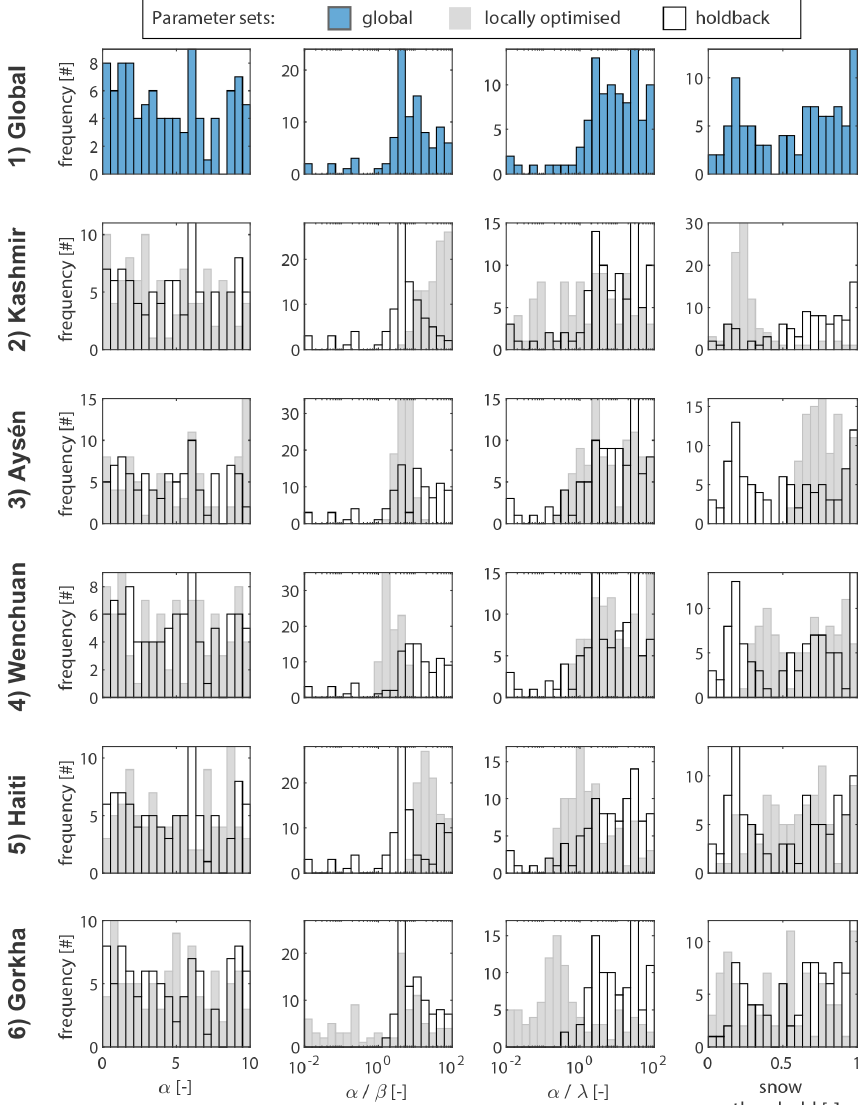
Figure 5. Posterior parameter distributions for the four parameters external to Google Earth Engine after global optimisation (top row) and local optimisation for each earthquake. Rows 2–6 show posterior frequency distributions for each ALDI parameter following local optimisation (grey bars) and the holdback parameter set derived from the global set excluding locally optimised parameters (hollow